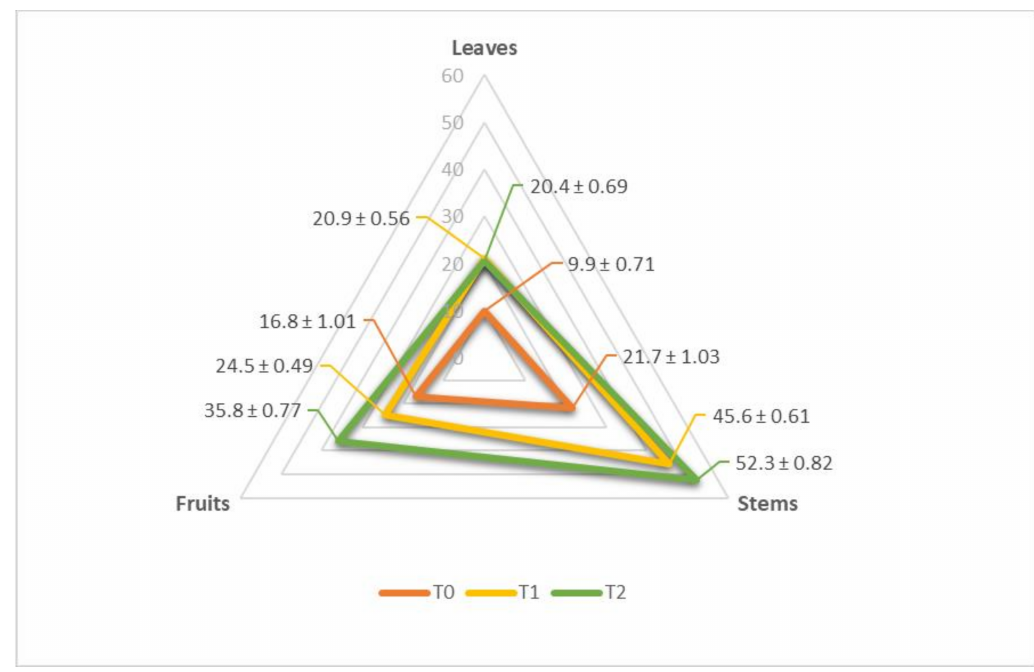
Figure 1. Accumulated selenium content ( µ g g − 1 ) in tomato components under sodium selenite